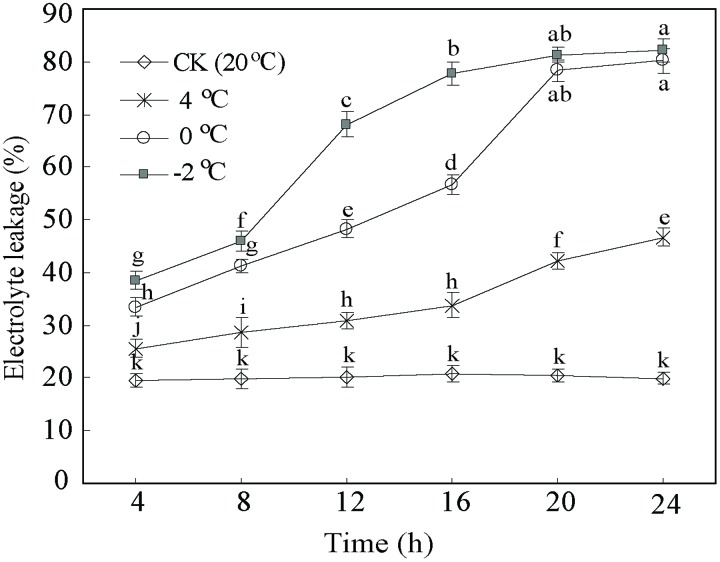
Cold tolerance expressed as electrolyte leakage of D. officinale under cold acclimation and control. Results are shown as means ± SD from three independent experiments. Different letters mark indicates significantly different at P < 0.01.